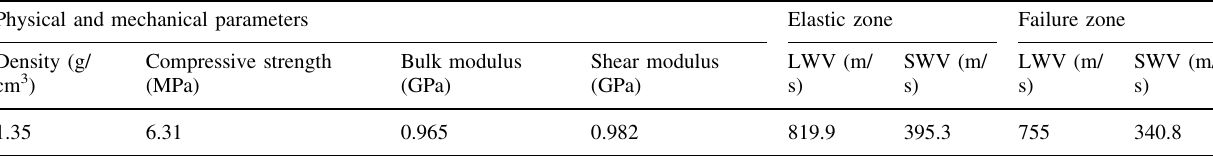
Table 1 Physical and mechanical properties Physical and mechanical parameters Elastic zone